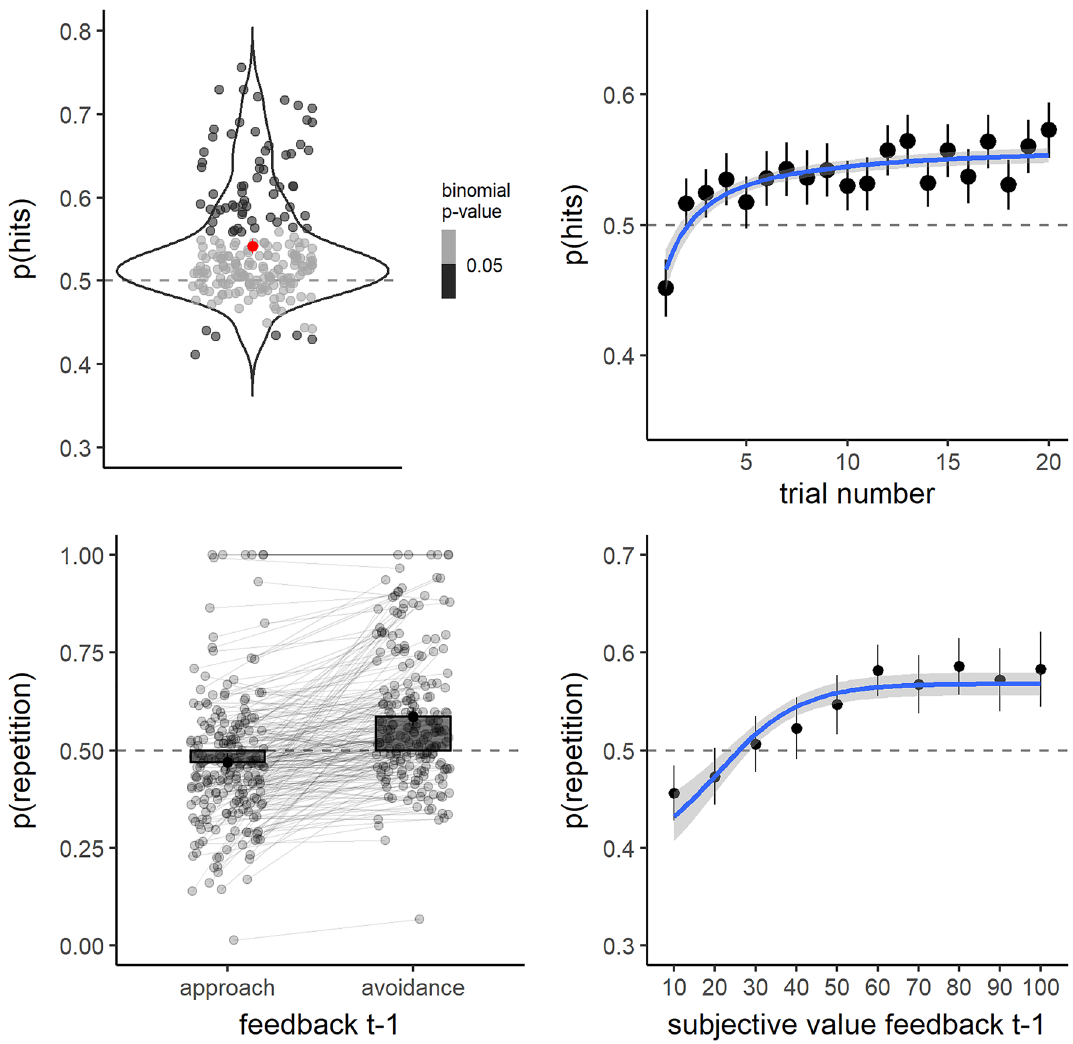
Figure 2. Summary of behavioral results. Left top: proportion of hits throughout the task. The red point represents the mean while the error-bar represents the confidence interval at 95% for the normal distribution. Shaded points represent single subject means while grey tones reflects whether, within each subject, the binomial test against chance (0.5) is significant (dark grey) or not (light grey). Right top: mean proportion of hits across the first 20 trials over blocks of stable action-outcome contingency (trial 1 = reversal trial). Points represent means within trial and error-bars represent confidence intervals at 95% for the normal distribution. The fitted curve represents the best fit (and 95% confidence interval) for the same hyperbolic function used in the mixed linear models (see “Methods”). Left bottom: mean proportion of action repetition following either approach or avoidance feedback. Black points represent means while error-bars represent confidence intervals 95% for the normal distribution. Shaded points represent single subject means. Right bottom: mean proportion of action repetition as a function of the subjective value attributed to the feedback obtained at t − 1. Black points represent means while error-bars represent confidence intervals 95% for the normal distribution. The fitted curve represents the best fit (and 95% confidence interval) for a logistic